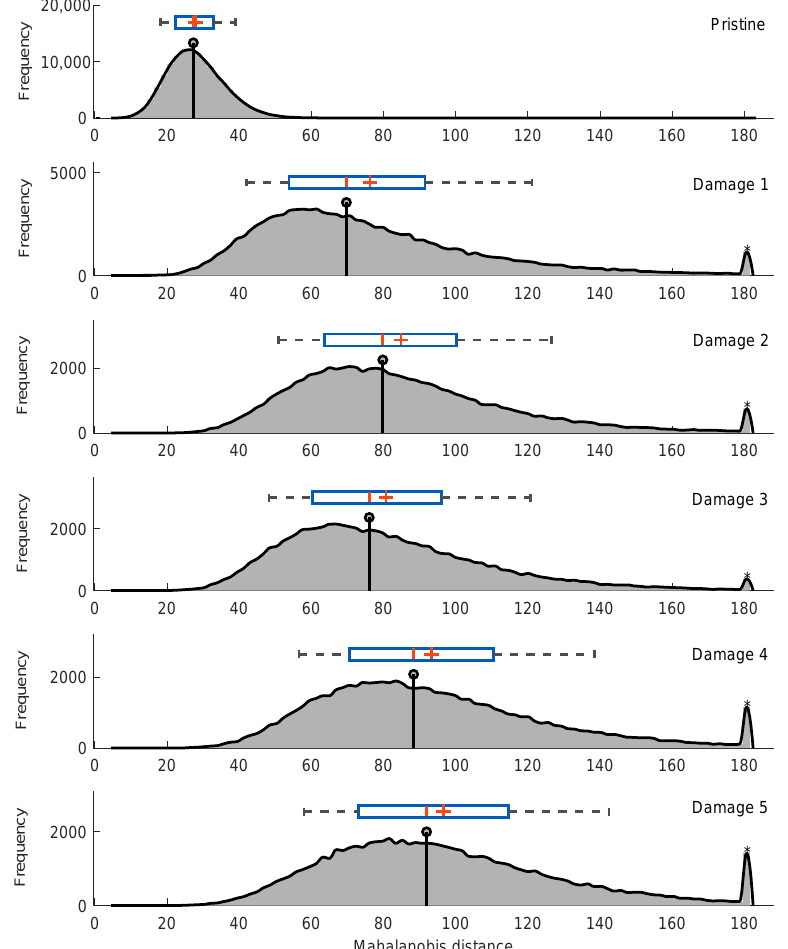
Figure 10. Mahalanobis distance vs. frequency for an excitation frequency of 20